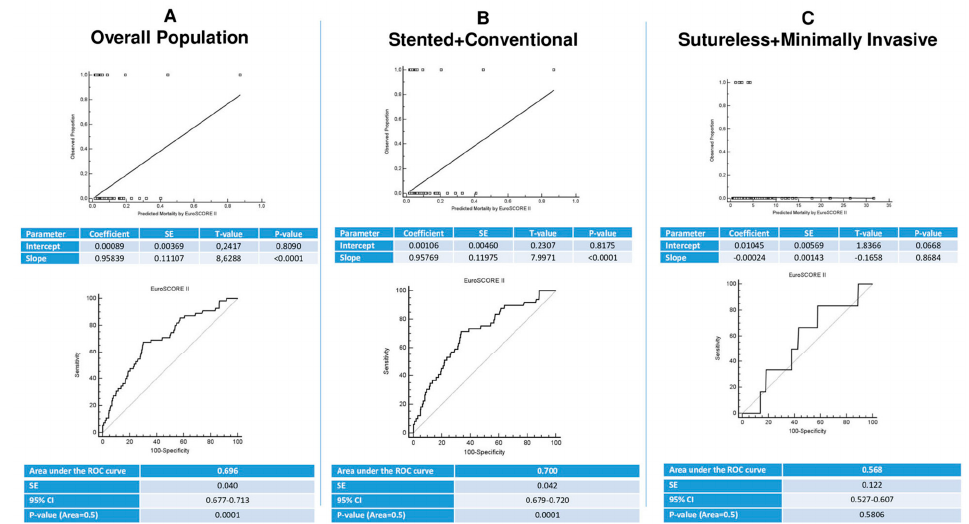
Figure 1. Calibration and discrimination of EuroSCORE II in the overall population. CI, confidence interval; SE, standard error; ROC, receiver operating characteristic.